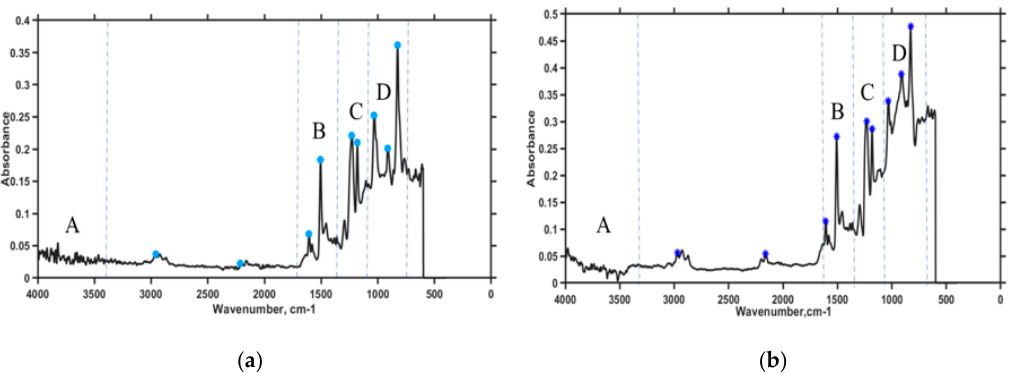
Figure 12. FTIR prepreg substrate SWCNT alignment characterization of samples ( a ) with no nanoparticles and ( b ) with Terfenol-D nanoparticles.